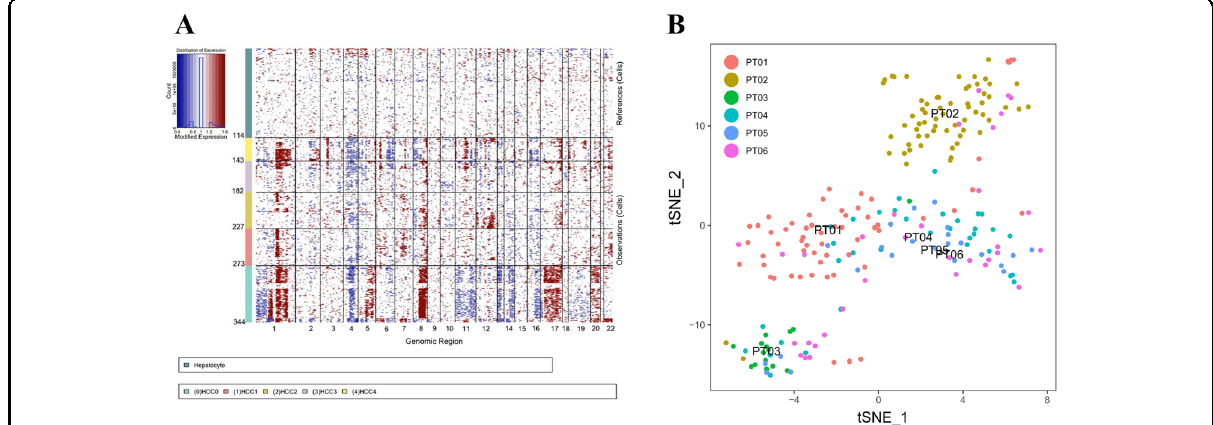
Fig. 2 Intra-tumoral heterogeneity at the single-cell transcriptional levels. A Chromosomal landscape of copy-number variations (CNV) distinguishes malignant from nonmalignant cells at transcriptomes. Red, ampli fi cations; blue, deletions. B A t-SNE plot of all the 405 single cells from six liver cancer patients (patients indicated by colors). Patients ’ ID was named as